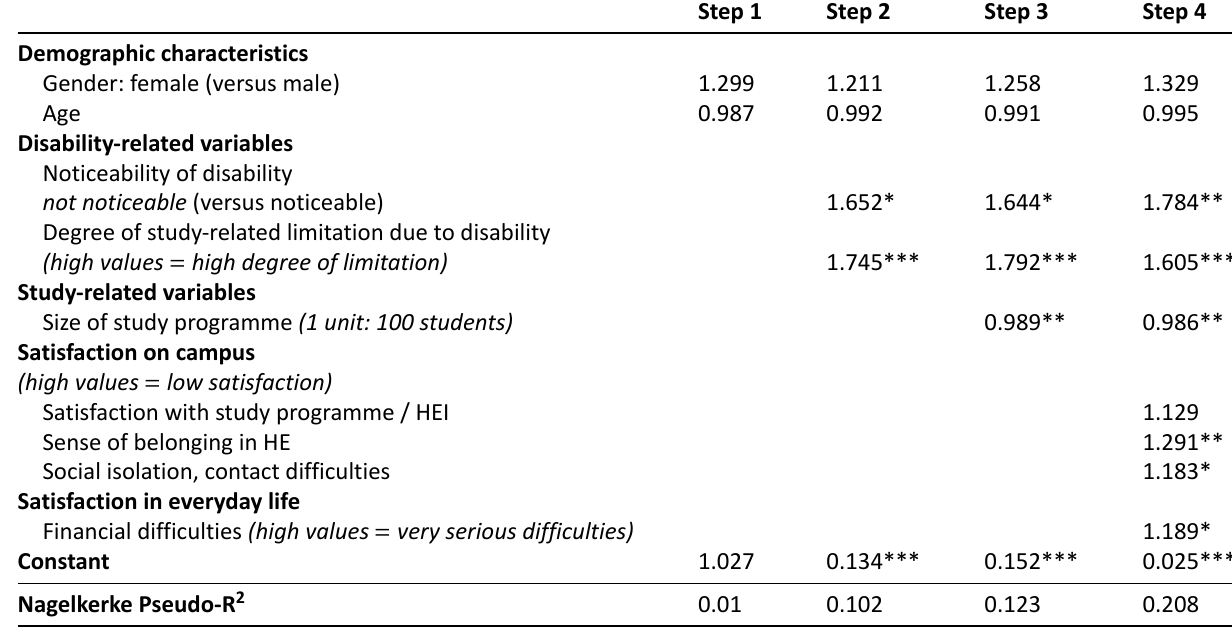
Table 3. Determinants of disabled students’ reluctance to seek support due to fear of stigmatisation: results of a logistic